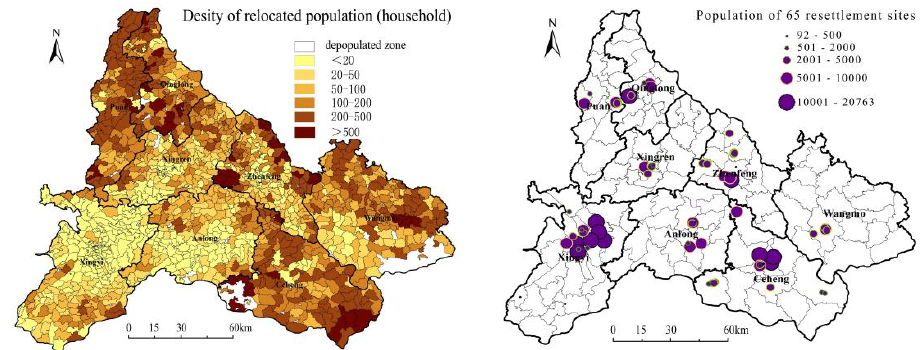
Figure 2. Density of relocated household and distribution of 65 resettlement sites of PAR.